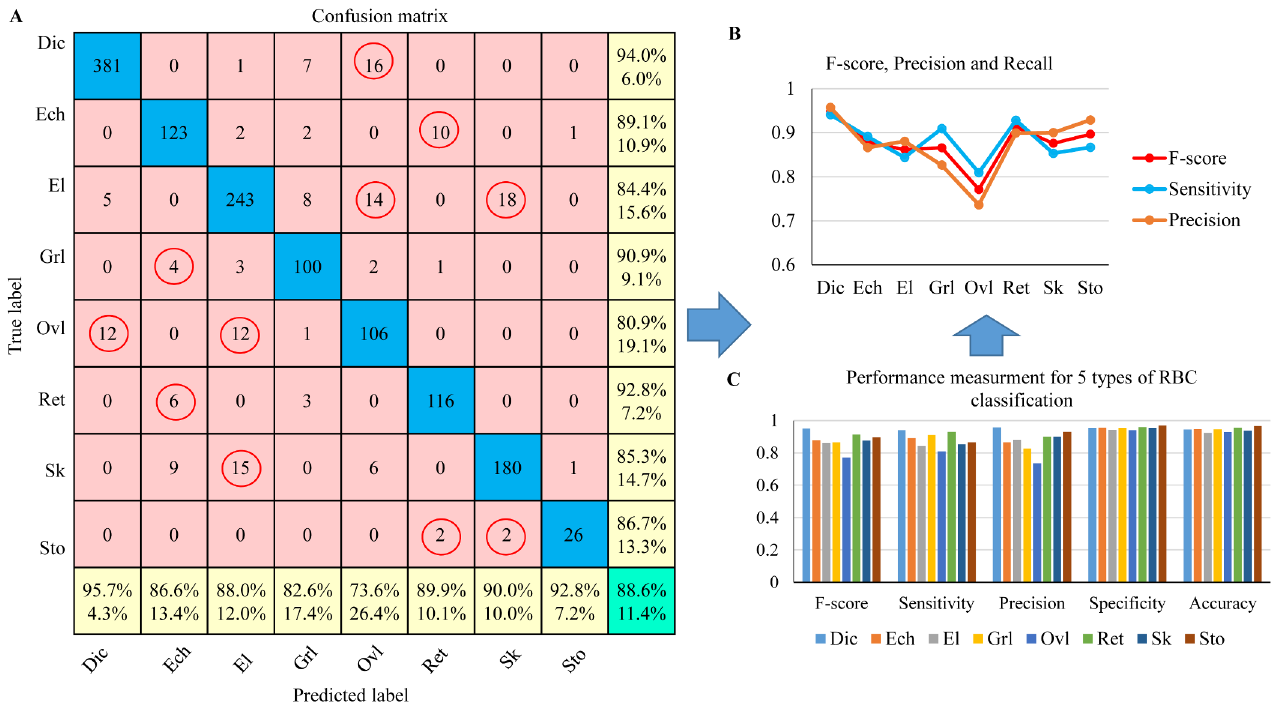
Fig 15. Classification performance analysis for SCD RBC classification based on “Exp_II” dataset (refined labeling). (A)confusion matrix showing the detailednumber of correctly classified RBC images and misclassified RBC images. (B) 5 statistic metrics for the 8 RBC category prediction result. (C) Specific F-score, precisionand recall analysisfor different RBC categories.